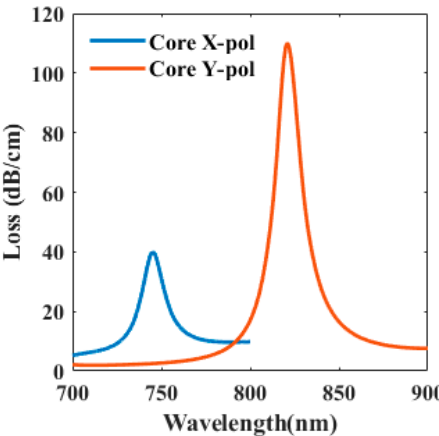
Figure 3. Comparison of the loss spectra of x-polarized fiber core mode and the loss spectra of y-polarized fiber core mode.